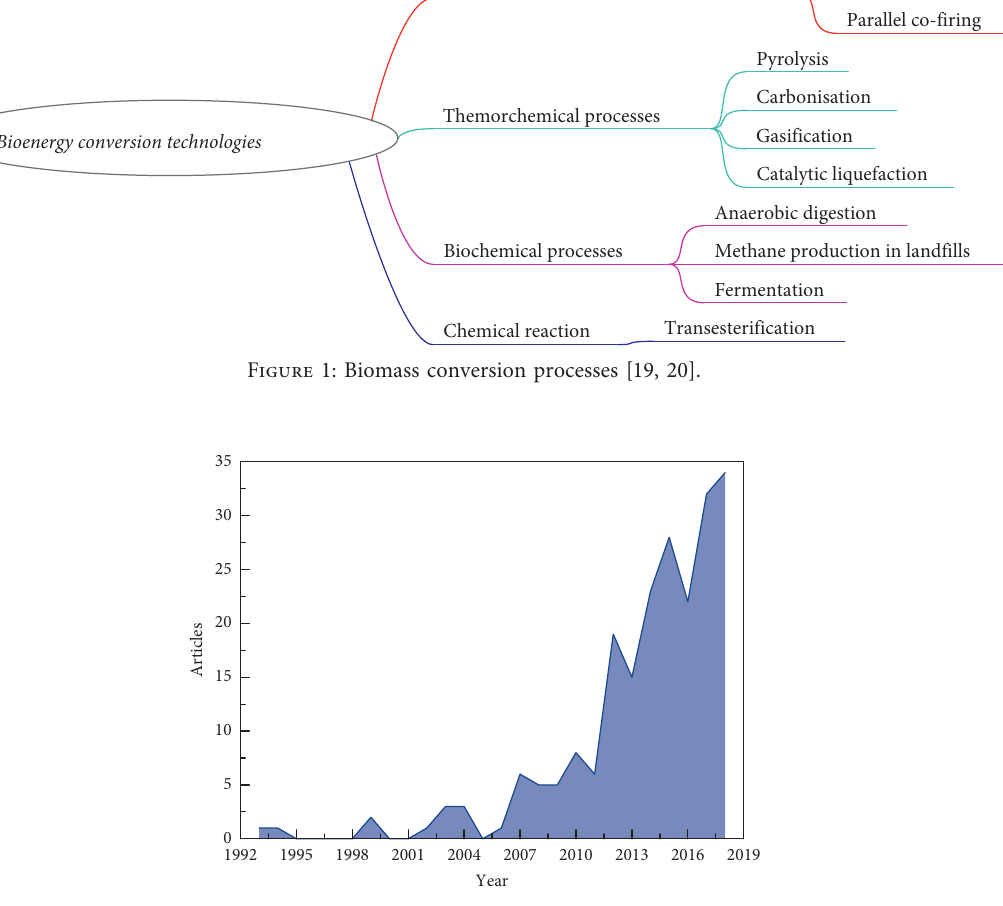
Figure 2: Annual scientific publication on the cothermal conversion of coal/sludge or coal/biomass appeared in the Web of Science